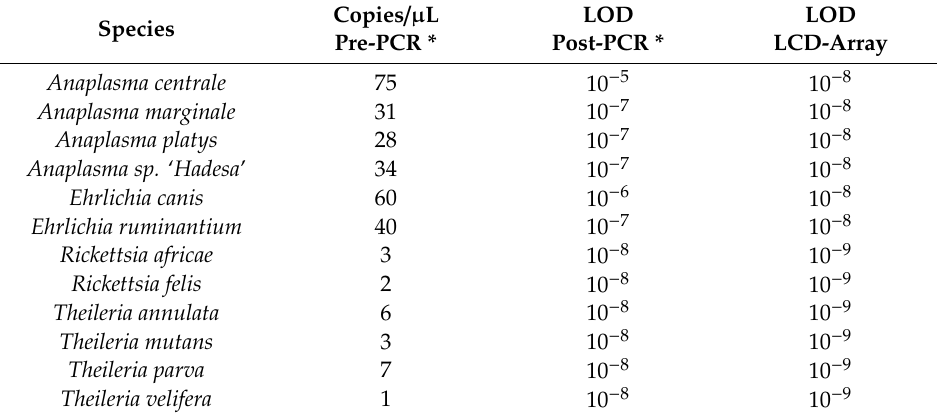
Table 2. Limit of detection (LOD) of LCD-Array for tick-borne pathogens measured in the lowest detectable dilution of the PCR product.